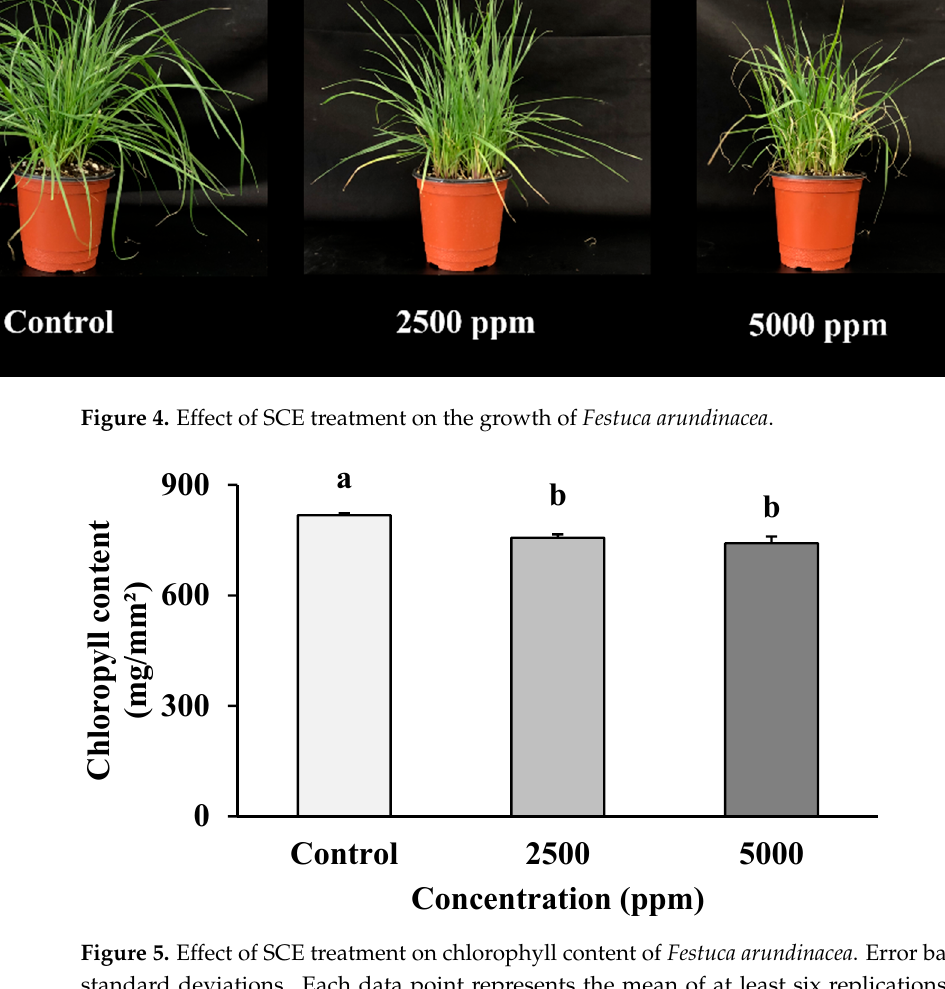
Figure 5. Effect of SCE treatment on chlorophyll content of Festuca arundinacea . Error bars represent standard deviations. Each data point represents the mean of at least six replications. Bars with different letters are significantly different from each other at p ≤